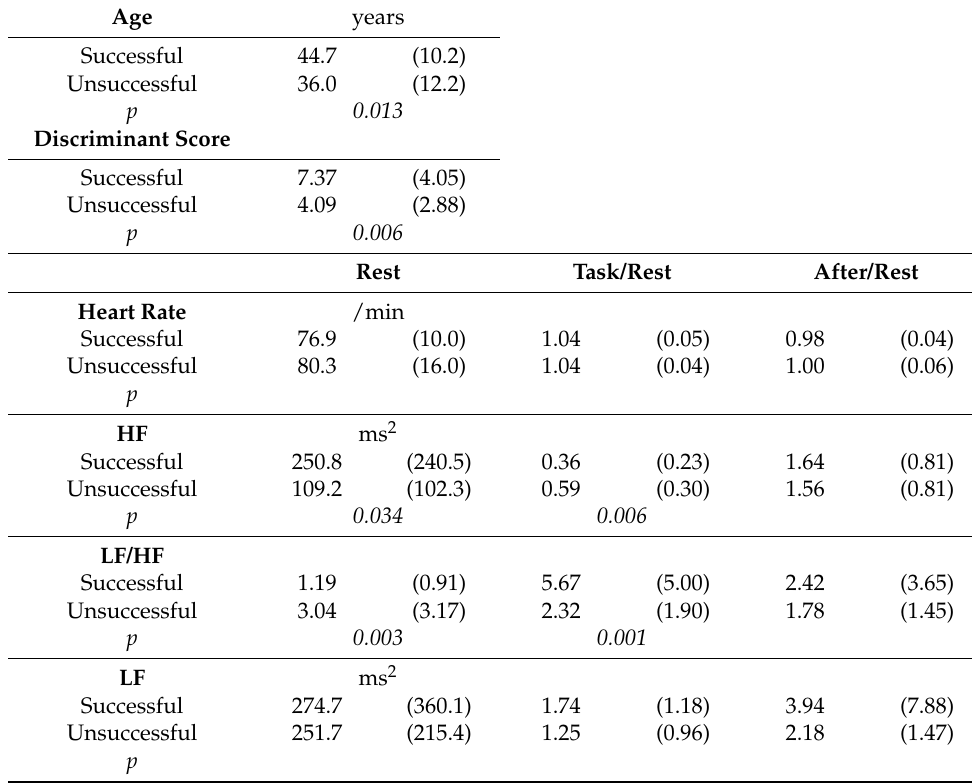
Table 2. Age, Discriminant Score, Heart Rate, and Heart Rate Variability Indices in Successful and Unsuccessful Returns with Positive Discriminant